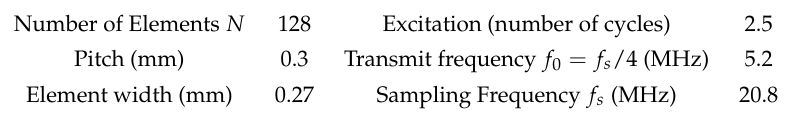
Table 1. Transmission settings for the PICMUS challenge